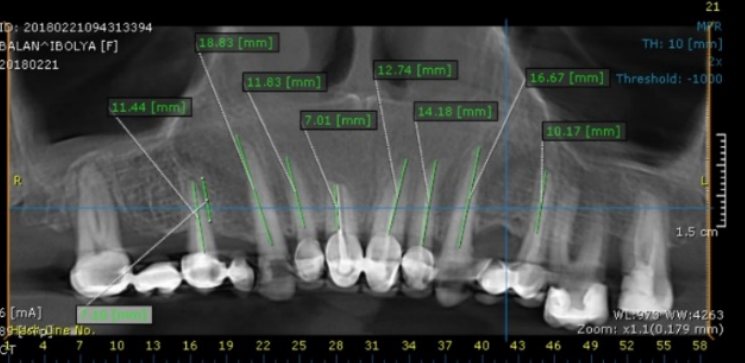
Figure 2. Evaluation of the periodontal status and root length of the maxillary teeth on CBCT .